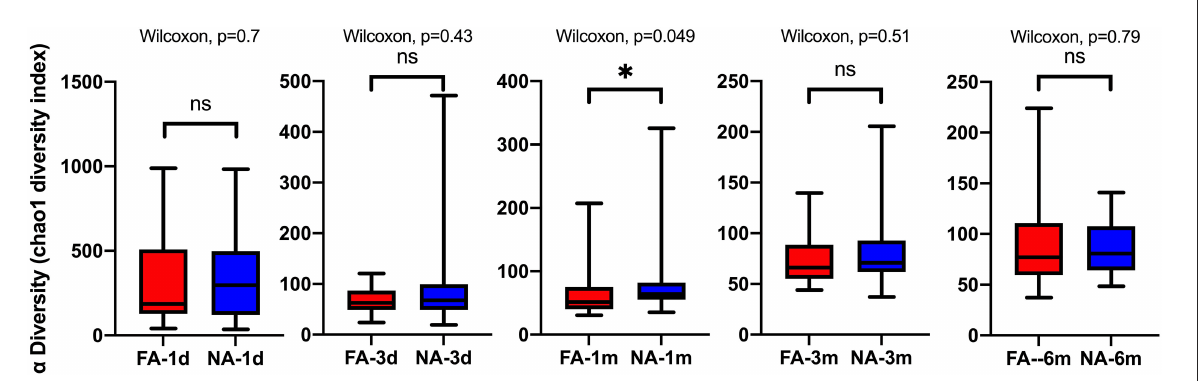
FIGURE3 Differences in the same-time alpha diversity between non-allergy (NA) and food allergy (FA) groups using the Chao1 index. The Wilcoxon test was used to assess differences between two groups at one time point. * P < 0.05; ns, not significant.